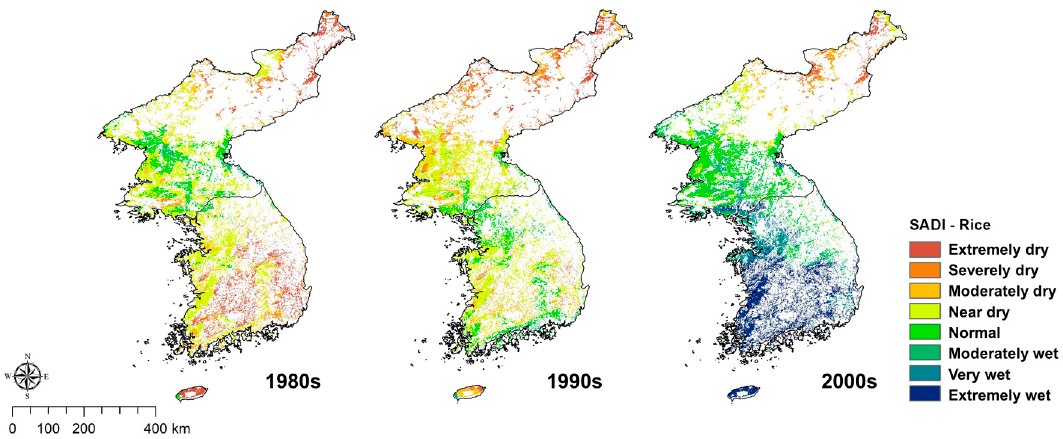
Figure 6. Spatial distribution of the Standardized Agricultural Drought Index for rice (SADI-Rice) for the 1980s, 1990s, and 2000s.